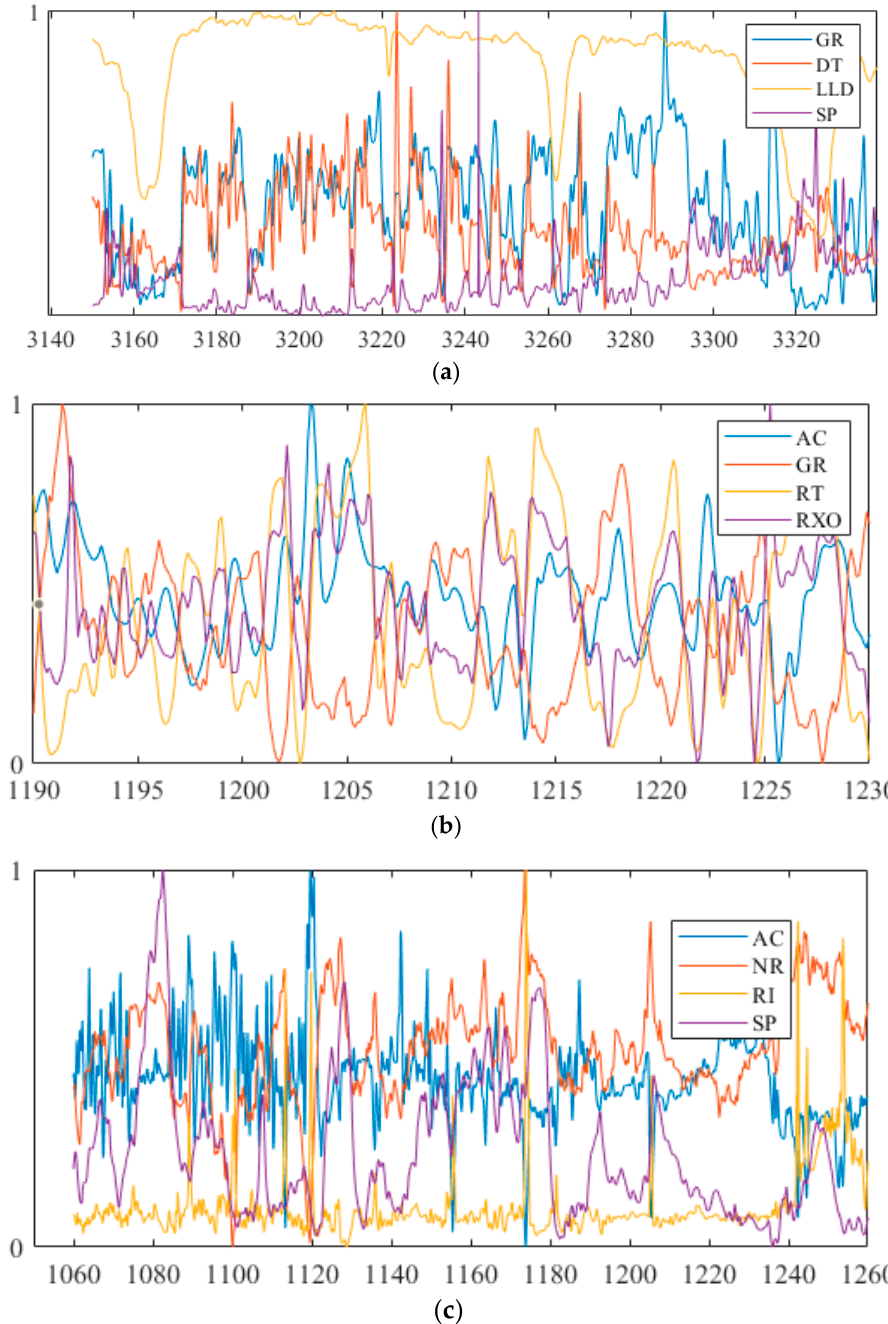
Figure 7. Attribute normalization curves: ( a ) partial attribute normalization of w 1 ; ( b ) partial attribute normalization curve of w 2 ; ( c ) attribute normalization curve of w 3 .